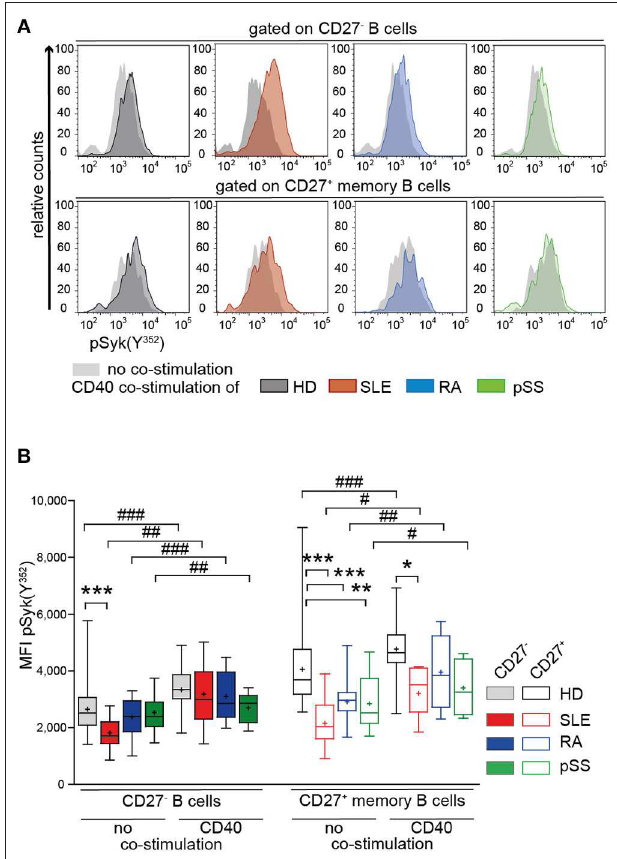
FIGURE 4 | Increased Syk(Y 352 ) phosphorylation reflecting BCR responsiveness of CD27 + memory B cells from HD, SLE, RA, and pSS upon co-stimulation with CD40L. PBMCs from HD (black), SLE (red), RA (blue), and pSS (green) patients were treated with CD40L and subsequently stimulated with anti-IgG/IgM F(ab) 2 . (A) Representative histograms of pSyk(Y 352 ) in CD27 − (top row) and CD27 + memory (bottom row) B cells in the presence (colored areas) or absence (gray areas) of prior CD40L co-stimulation. (B) pSyk(Y 352 ) in CD27 − (filled boxes) and CD27 + memory (clear boxes) B cells with [n(HD/SLE/RA/pSS) = 11/7/5/5] and without [n(HD/SLE/RA/pSS) = 30/18/16/15] CD40 co-stimulation. Box whisker plots represent median (line), mean (plus), and the range from minimum to maximum (ANOVA with DMCT, * p ≤ 0.05, ** p ≤ 0.01, *** p ≤ 0.001; paired t -test, # p ≤ 0.05, ## p ≤ 0.01, ### p ≤